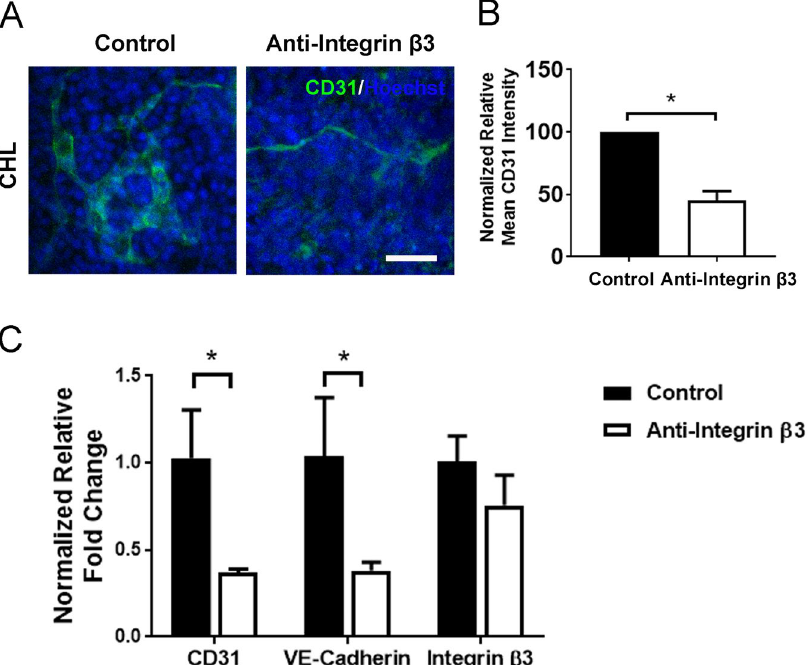
Figure 6. Inhibition of integrin β 3 using neutralization antibody. ( A ) Representative confocal images of ESCs (H1) differentiated for 5 days on Tier I combinatorial ECM (CHL). Prior to the start of differentiation and throughout the differentiation time course, ESCs were treated with integrin β 3 neutralizing antibody (right) or IgG antibody (left). ( B ) Quantification of CD31 protein expression shows a significant reduction in endothelial differentiation as a result of integrin β 3 inactivation (n = 3). ( C ) Quantitative PCR shows a significant reduction in gene expression in CD31 and VE-cadherin (n = 3). * Denotes P <